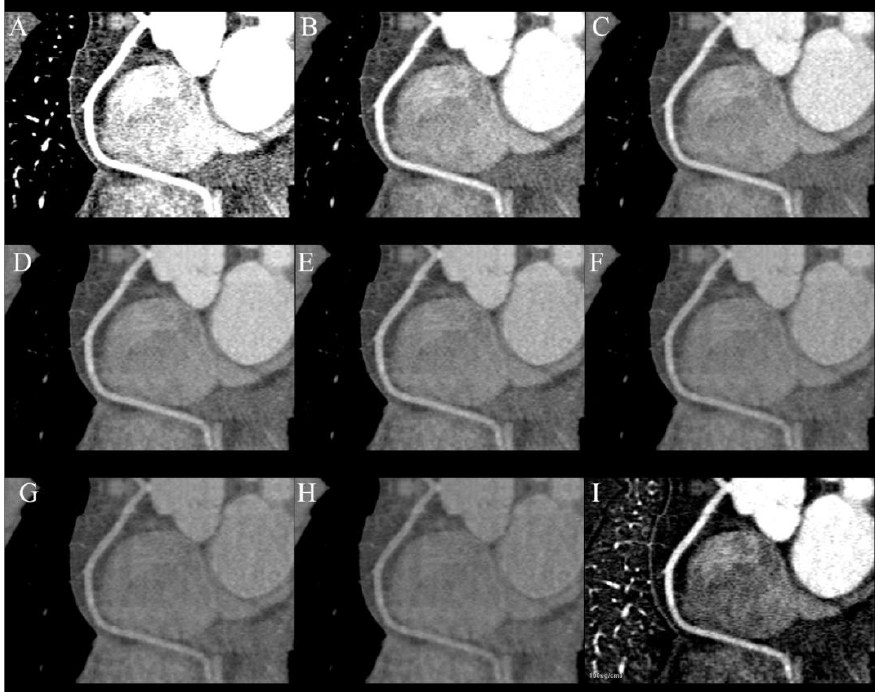
Figure 2. Series of curved MPR of RCA at different energy VMIs: ( A ) — 40 keV, ( B ) — 50 keV, ( C ) — 60 keV, ( D ) — 70 keV,